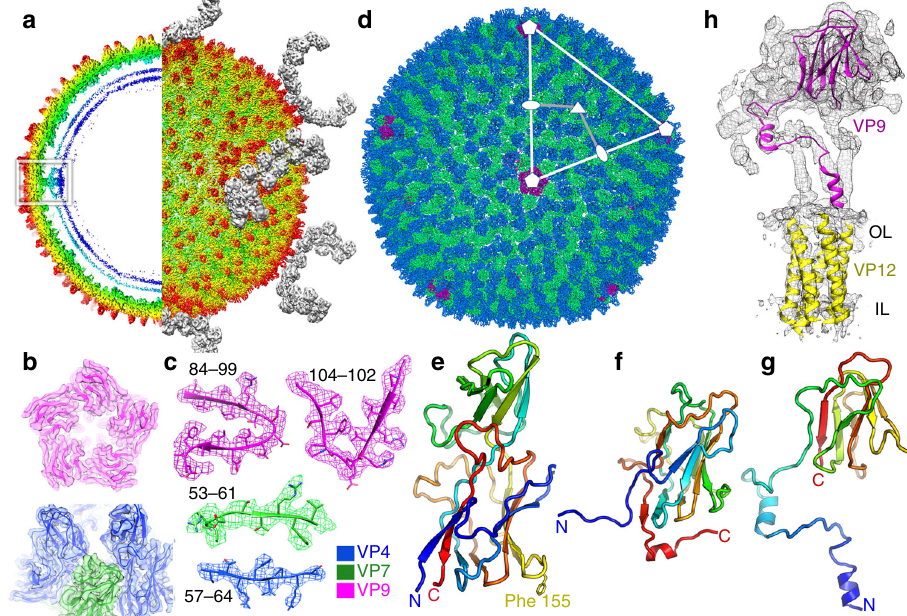
Fig. 1 SH1 structure overview. a Radially coloured SH1 cryo-EM map, a central section is shown to the left and the outer view to the right. Horn-like spikes are shown correctly positioned on the surface in grey. The white inset box marks the 5-fold vertex structure. VP4 turrets are red and the headgroups of the outer and inner lea fl ets of the membrane are in cyan and blue respectively. b , c Representative density with fi tted structures for VP4 (coloured blue), VP7 (green) and VP9 (magenta), b shows an overview and c shows close-ups (residue ranges are indicated for each). d Overall structure of SH1. Representative 5-fold, 3-fold and 2-fold axes are indicated and the white-grey kite shape delimits an icosahedral asymmetric unit. The outer diameter is ~800 Å. e Cartoon representation of VP4, rainbow coloured from the N-terminus (blue) to C-terminus (red). f Similar style cartoon representation of VP7. g Similar style cartoon of VP9. h Cryo-EM map after blurring (with a B-factor of 100 Å 2 ) extracted from the 5-fold vertex region (white box in a ), showing a subunit of VP9 (magenta) and transmembrane helices of fi ve copies of VP12 fi tted to the density (OL outer lea fl et, IL inner lea fl